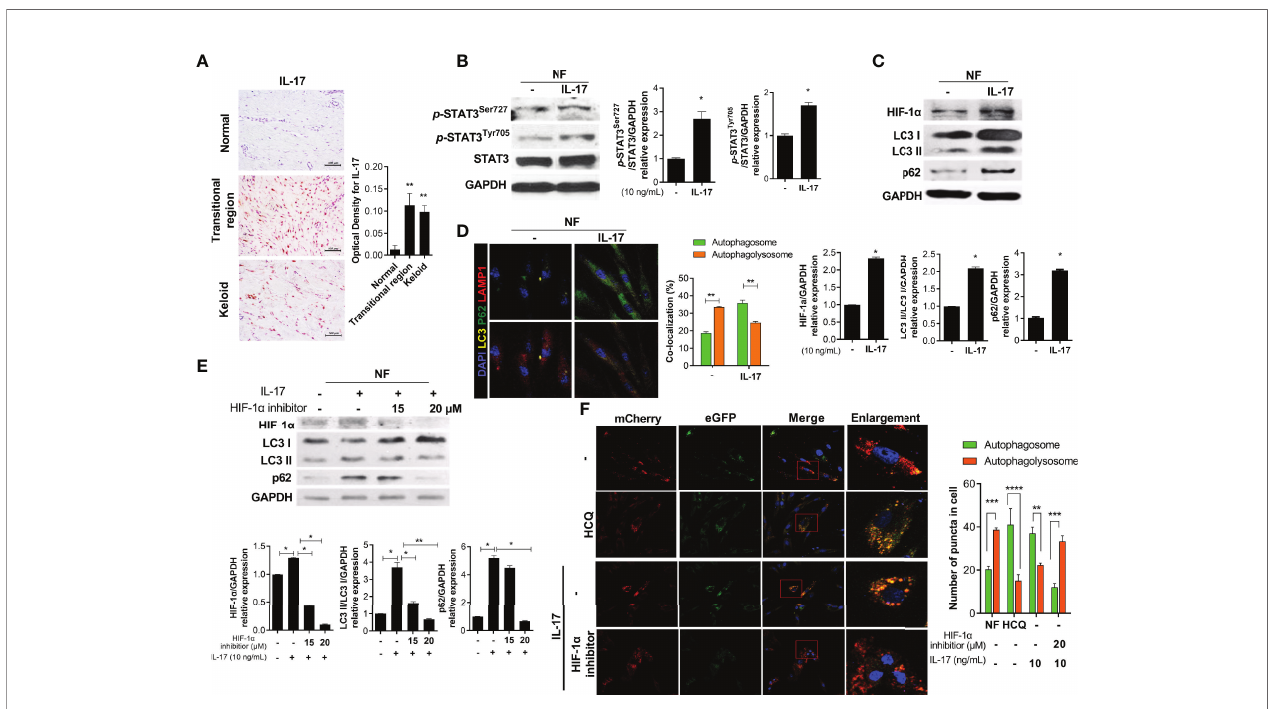
FIGURE 2 | IL-17 promotes activation of STAT3 and HIF-1 a , causing defective autophagy. (A) Keloid tissues were subjected to IHC for IL-17. (B, C) NF was stimulated with IL-17 for 48 h and the protein levels of p -STAT3 Tyr705 , p -STAT3 Ser727 , STAT3, b -actin, HIF-1 a , LC3I/LC3II, p62, and GAPDH were analyzed by Western blotting. (D) Autophagosomes and autophagolysosomes in IL-17-treated NF were analyzed by confocal microscopy. Merging of LC3 (yellow), p62 (green), and DAPI (blue) indicates autophagosomes; Merging of LC3 (yellow), LAMP1 (red), and DAPI (blue) indicates autophagolysosomes. (E) NF were stimulated with IL-17 (10 ng/mL) and HIF-1 a inhibitor (15 or 20 m M) for 48 h. Protein levels of HIF-1 a , LC3I/LC3II, p62, and GAPDH were analyzed by Western blotting. (F) pBABE-puro mCherry-EGFP-LC3B DNA vector was transfected to NF, which were cultured with IL-17 and an HIF-1 a inhibitor (20 m M) or HCQ (20 m M) for 48 h. Autophagosomes (bright yellow) and autophagolysosomes (bright red) were analyzed by confocal microscopy. Bar graph shows data from one of three independent experiments; results are means ± SD of three independent experiments per group (* P < 0.05, ** P < 0.01, *** P < 0.001, **** P <